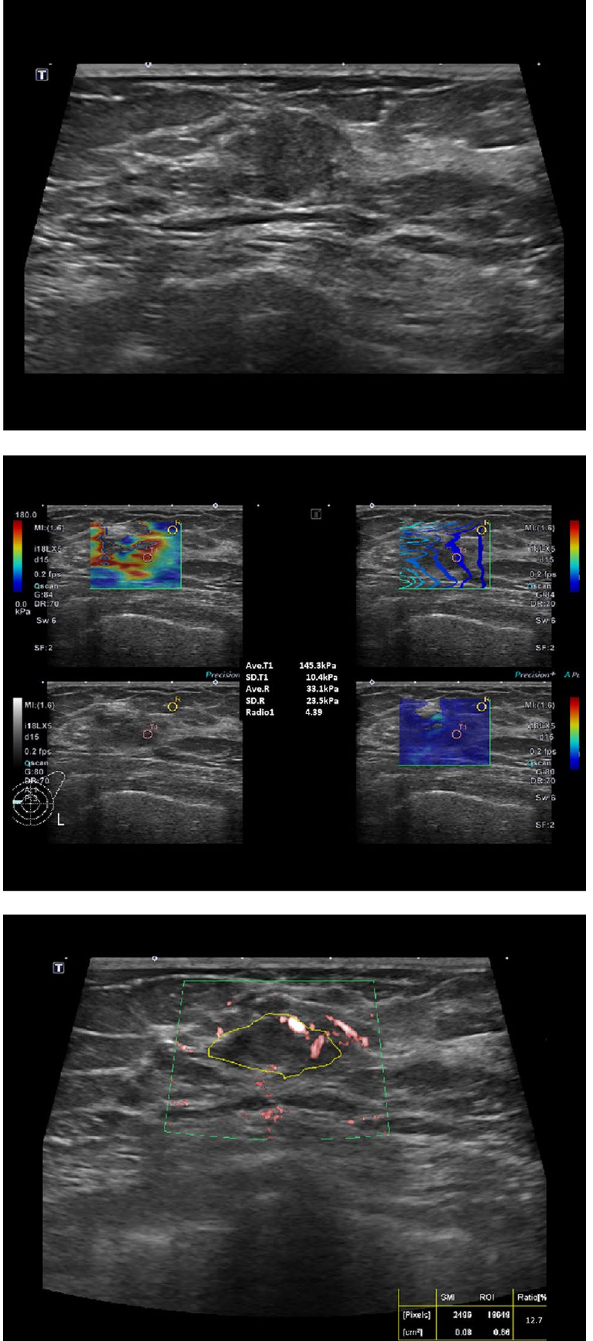
Figure 3. A 79-year-old woman with proven invasive ductal carcinoma. ( A ) B-mode ultrasound was a 1.5 cm-sized mass categorized as C4a. ( B ) The SWEmax was 145.3 kPa and the SWE ratio was 4.39. ( C ) The SMI vascular index was 12.7% over the cutoff value. The combined score was 4, indicating that the lesion was considered malignant lesion and the pathologic diagnosis was IDC grade I with